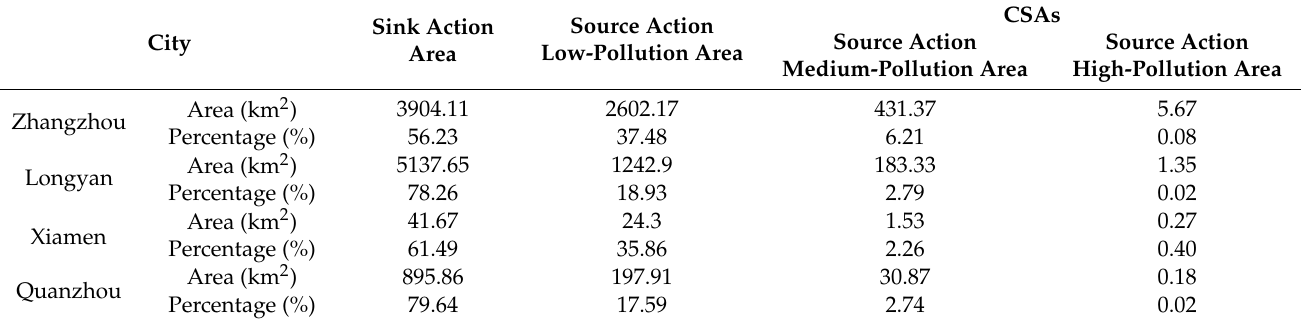
Table 3. The area and percentage of NPS pollution CSAs in the cities of the Jiulong River